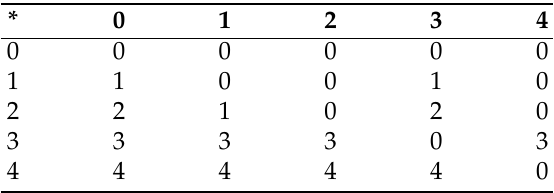
Table 5. Cayley table for the binary operation “ ∗ ”.